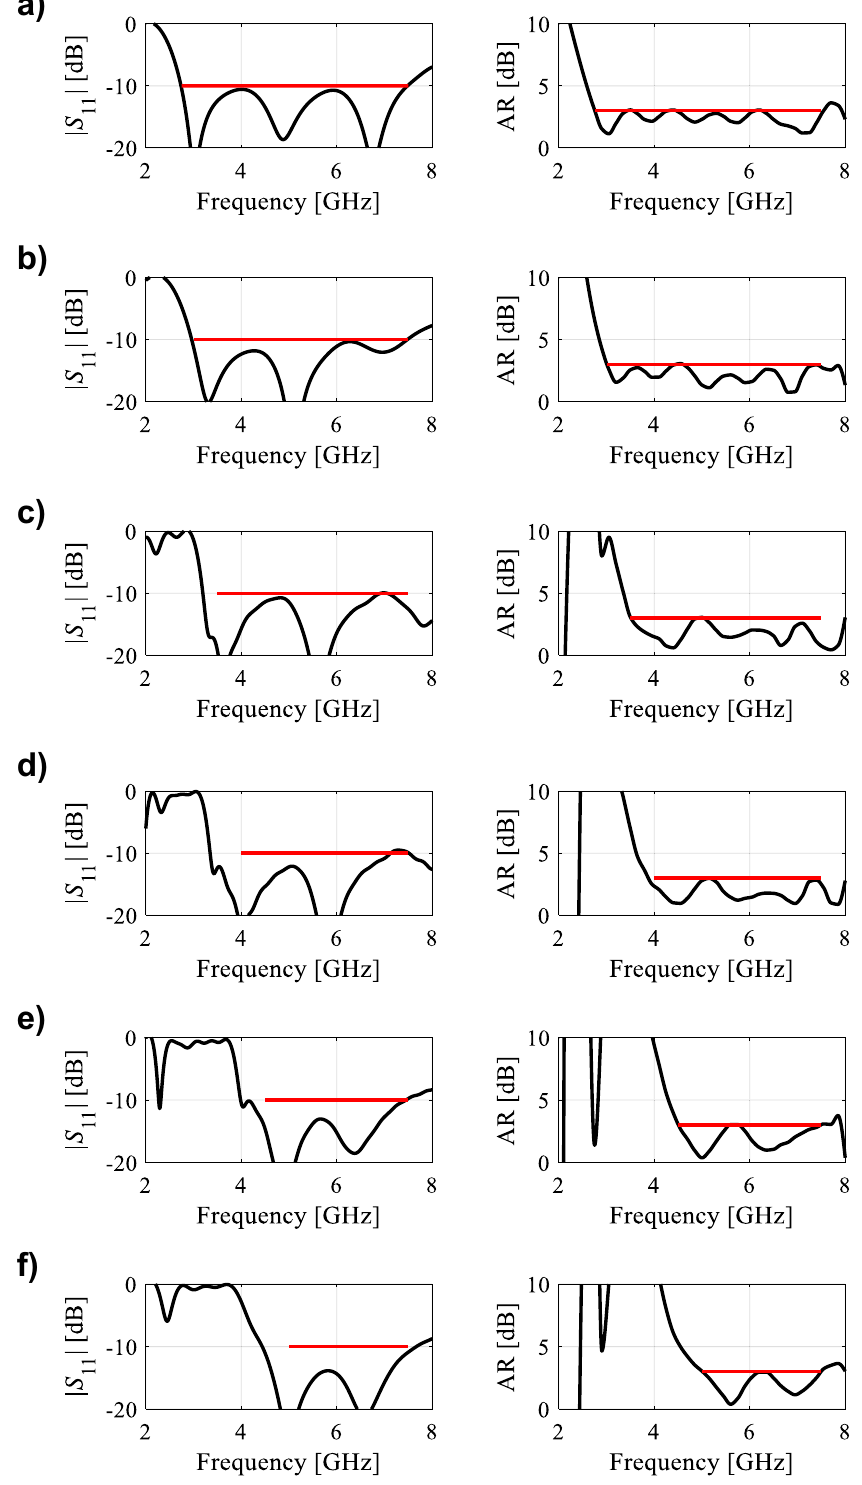
Figure 14. Trade-off designs for the CP antenna of Fig. 10: reflection (left) and axial ratio (right) responses. Horizontal lines represent the target operating bandwidth: ( a ) f L = 2.75 GHz, ( b ) f L = 3.0 GHz, ( c ) f L = 3.5 GHz, ( d ) f L = 4.0 GHz, ( e ) f L = 4.5 GHz, ( f ) f L = 5.0